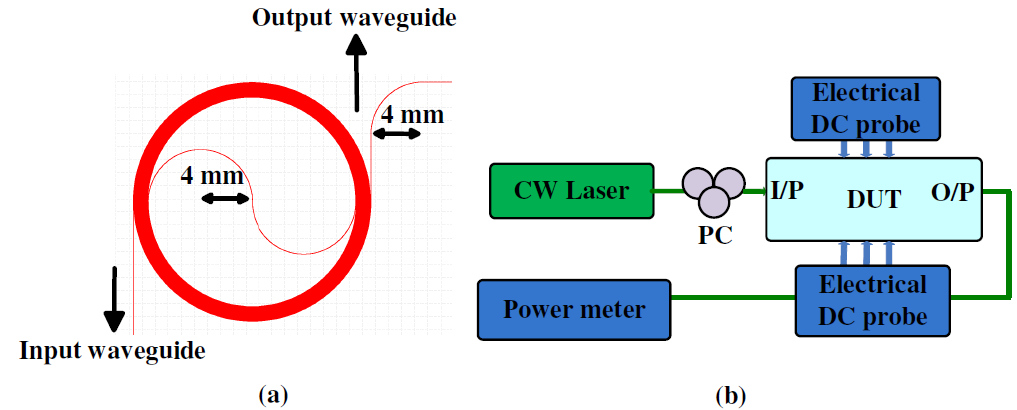
Figure 7. ( a ) Layout of the 1.5 m long spiral waveguide, ( b ) Experimental setup to measure the transmission responses of the different test devices, (10 cm long waveguide, 1.5 m